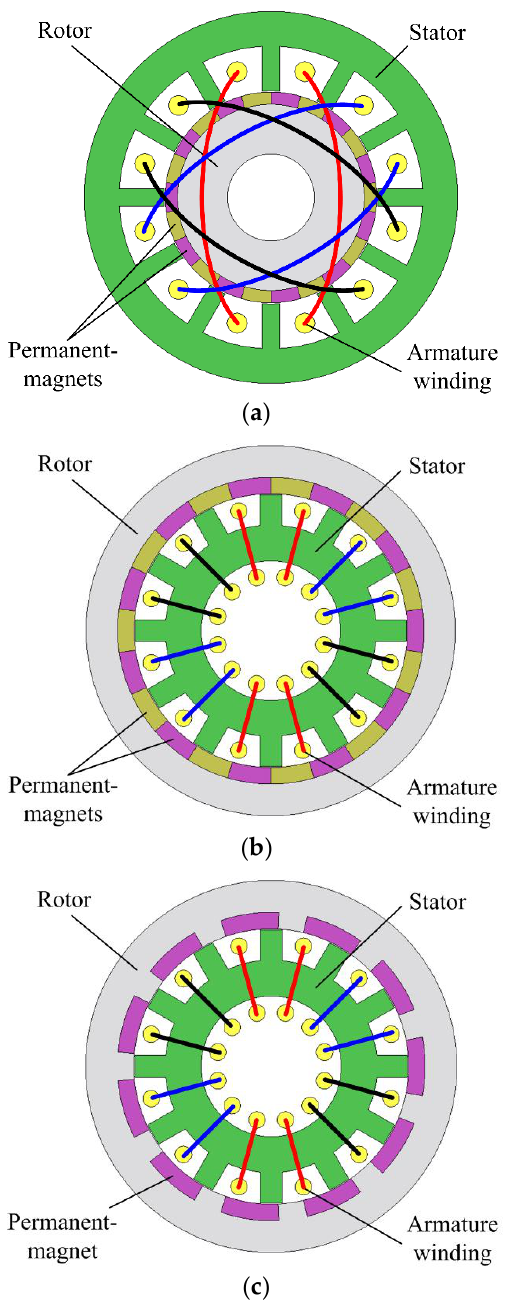
Figure 1. Vernier permanent-magnet (VPM) motors: ( a ) IR (Inner-Rotor)-VPM; ( b ) OR (Outer-Rotor)-VPM and ( c ) OR-CP (Consequent-Pole)-VPM.